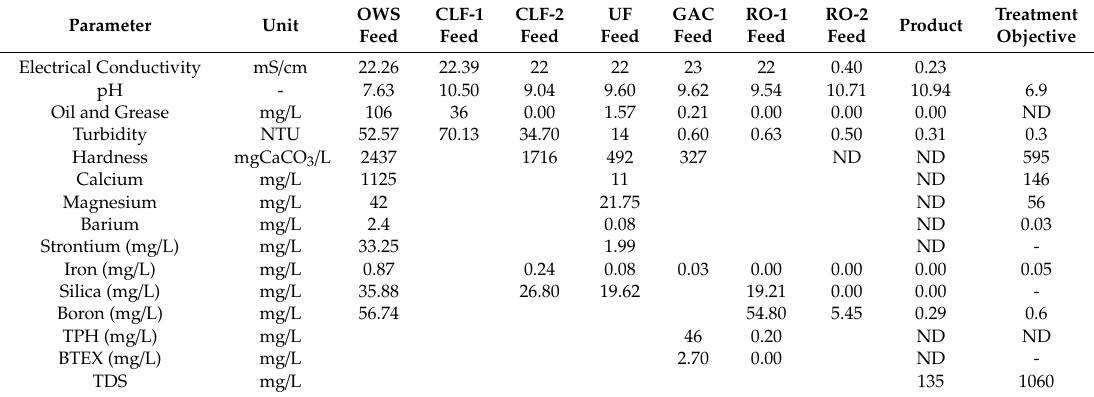
Table 7. Changes in concentrations of water quality parameters across di ff erent process unit